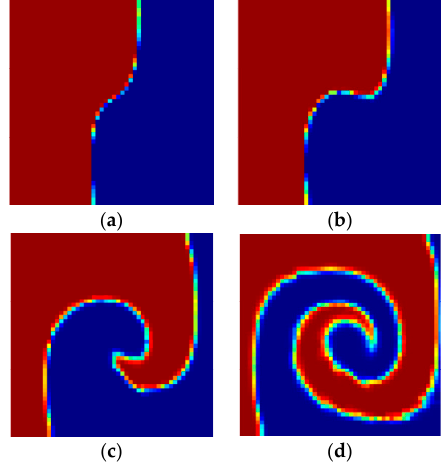
Figure 8. The evolution of mixing performance of micromixers with different cycles which the single cycle is the layout in Figure 5: ( a – d ) are the distribution of coarse grain concentration on the outlet with 1, 2, 5, and 10 cycles, and J ( C ) are 0.9882, 0.9779, 0.9404 and 0.8413, respectively.